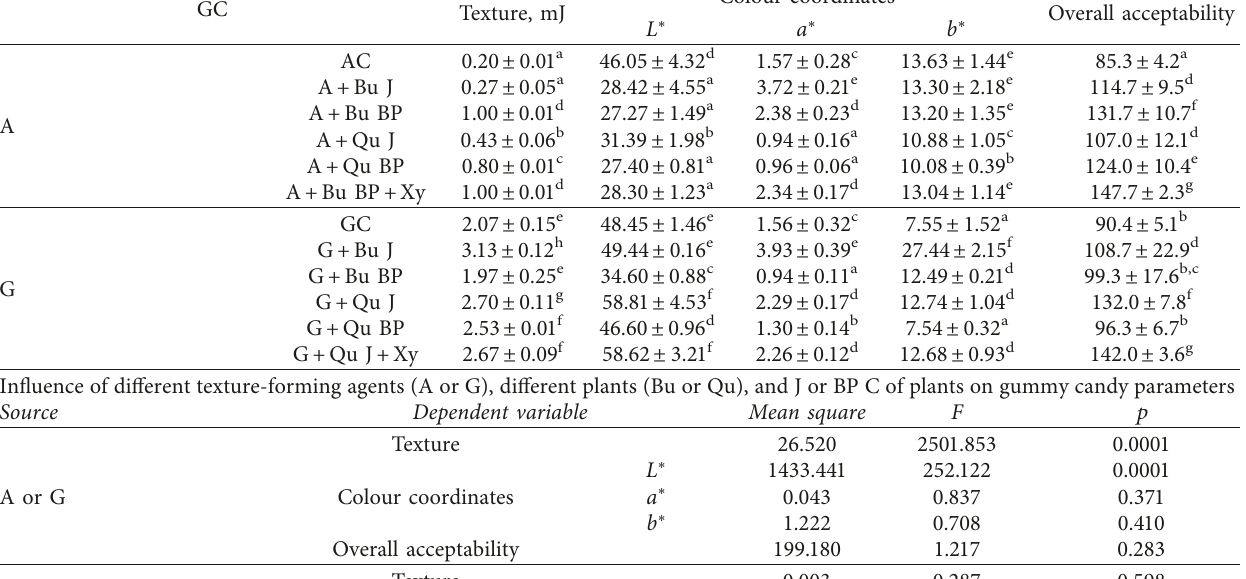
Table 3: Hardness, colour coordinates, and overall acceptability of gummy